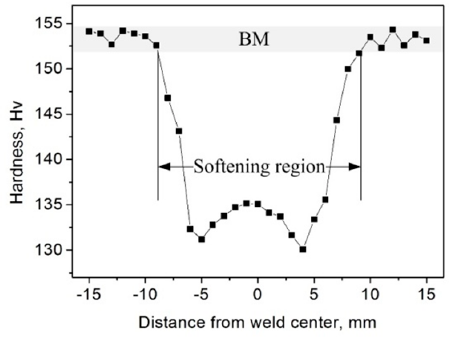
Figure 10. Hardness profile measured across the middle of the top sheet of a FSLW joint (100 mm/min).